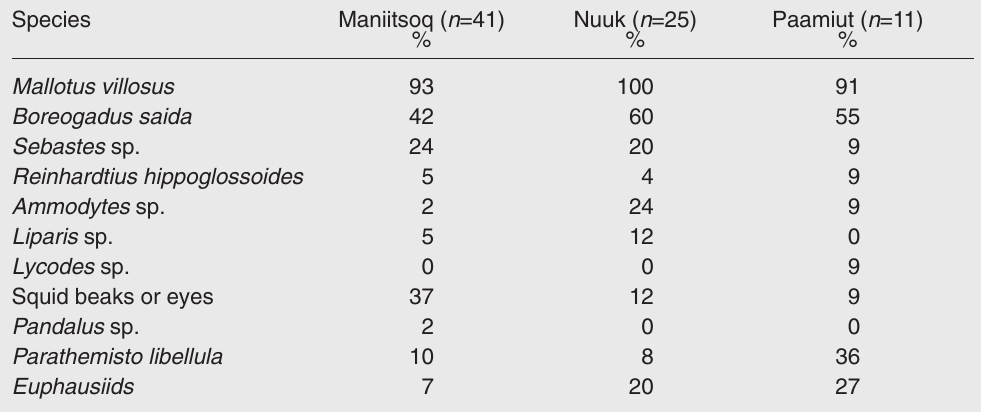
Table 7. Food preferences of harbour porpoises in West Greenland. The percentage of stom- achs with each prey item is given for the 3 districts (sample size in parentheses). The total number of stomachs with prey remains was 78.